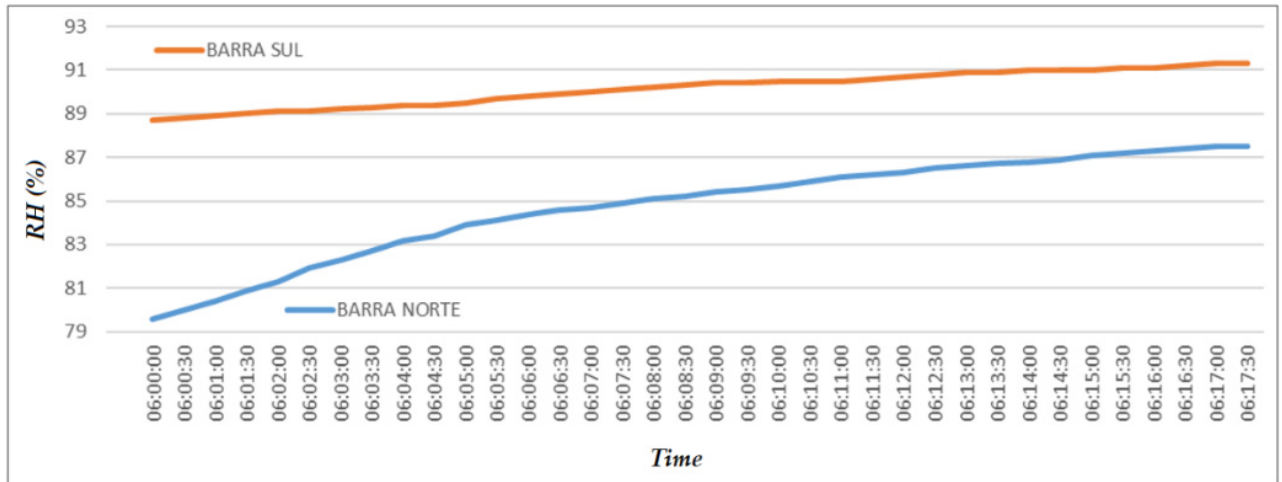
Figure 11. Chart of the variability in RH at the fixed points.